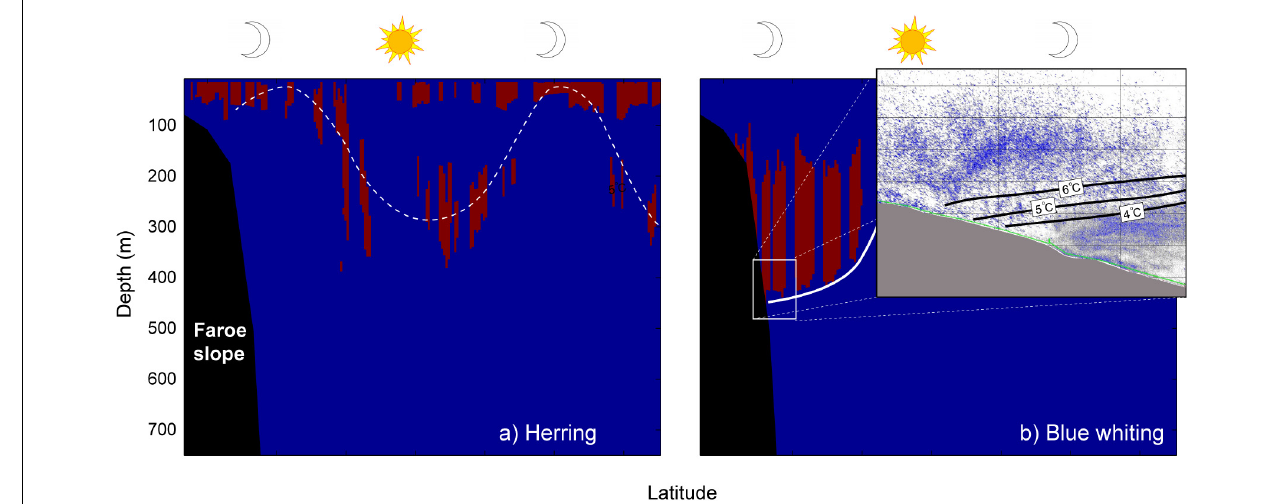
FIGURE 9 | Scruitinized acoustic backscatter from the ship-mounted echo-sounder. Distribution of (A) herring and (B) blue whiting. Times of day and night are cartooned with a sun and a moon, respectively. The dashed undulating curve in (A) illustrates DVM in the herring distribution and the white line in (B) illustrates the position of the interface (see Figure 1C ). The inset panel in (B) shows acoustic backscatter, in the location where the interface intersects the seafloor (see Figure 1C ). This is obtained as a screen shot from the software Echoview R (cid:13) , and the position of the three isotherms is estimated from Figure 1C